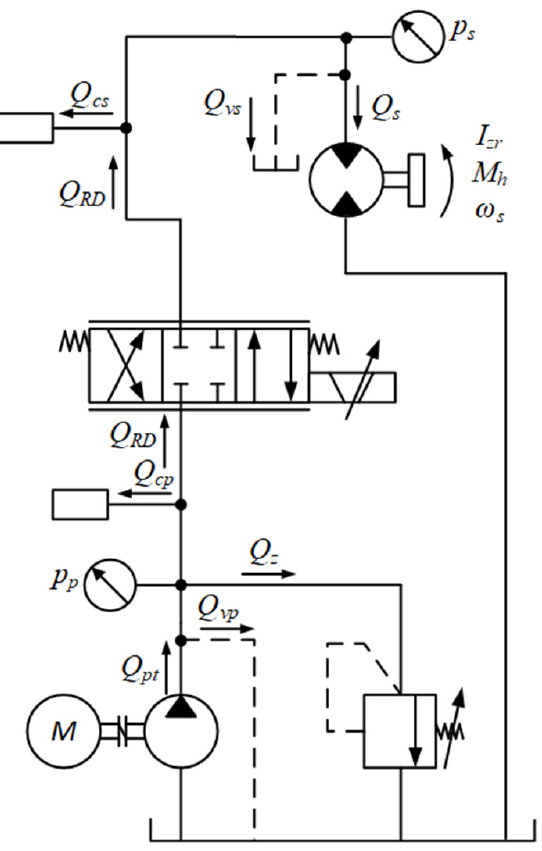
Figure 1. Diagram of the hydraulic system of a hydrostatic transmission with serial throttle control.